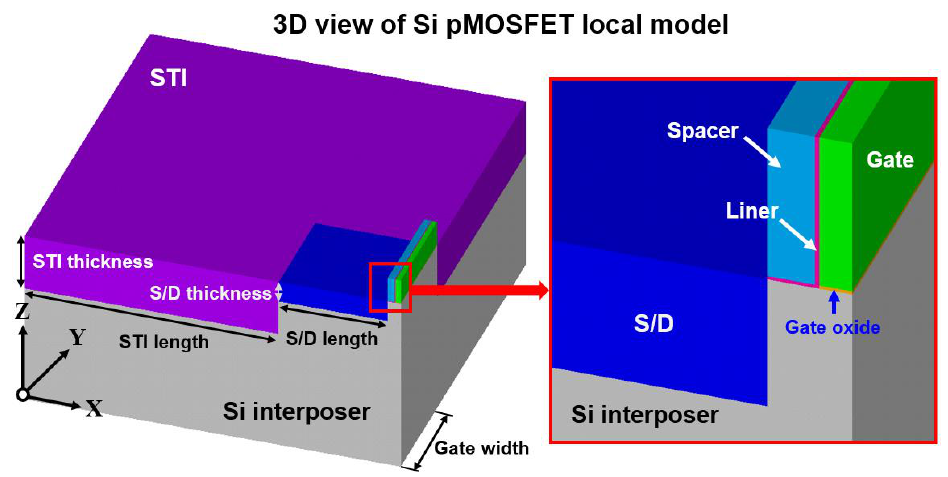
Figure 4. Schematic of a local Si pMOSFET FEA model and the corresponding structural parameters and components.